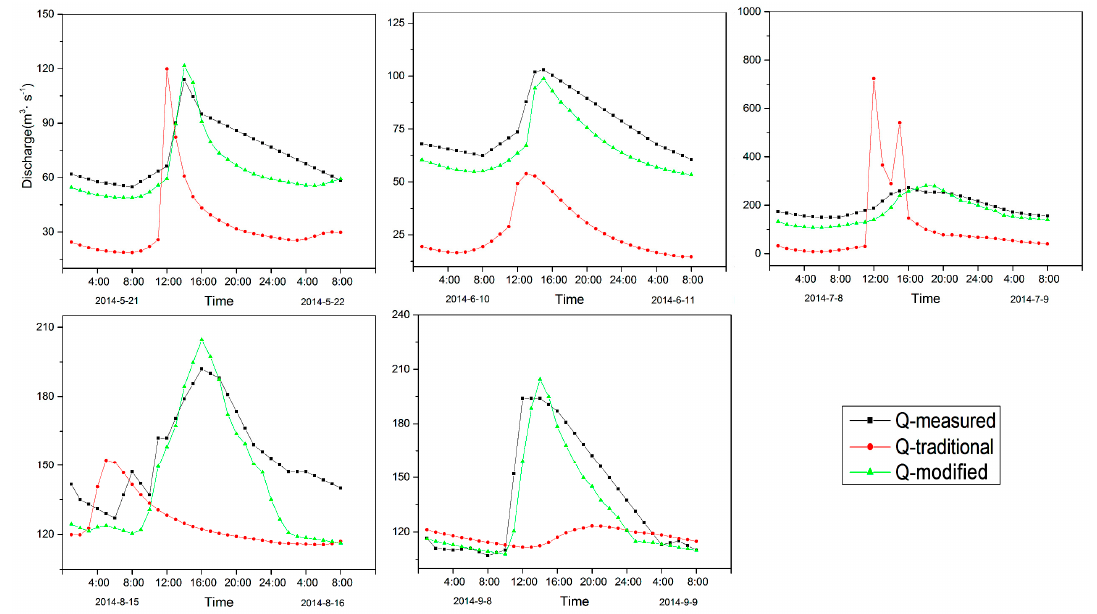
Figure 7. Simulation results of the improved model on an hourly scale during the validation